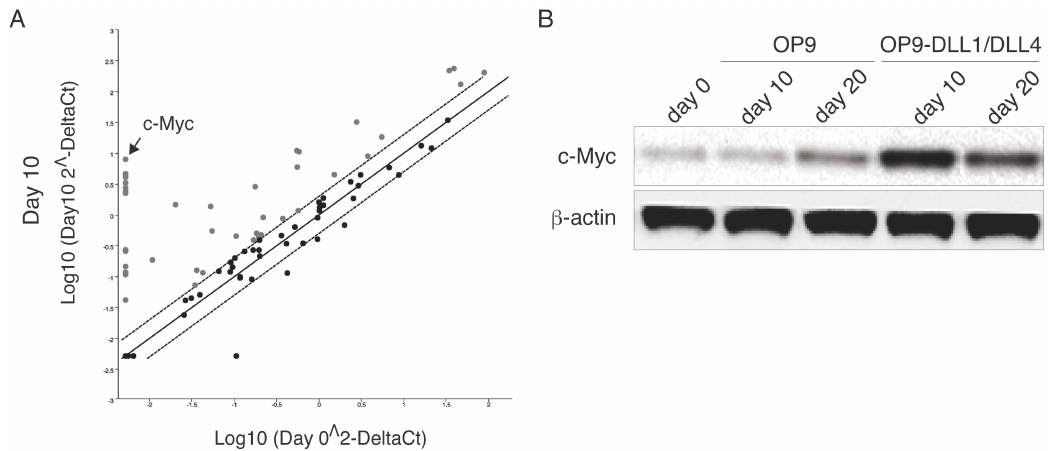
Figure 2. Notch signaling regulates c-Myc during HSC-T cell differentiation. Bone marrow–derived CD117 + HSCs from OT-I TCR transgenic mice were co-cultured with OP9-DLL1/DLL4 or OP9 cells. HSC-derived cells were isolated by gentle repetitive pipetting and centrifuging of the pipetting cells. ( A ) The scatter plots of PCR Array analysis. At days 0 and 10, total RNA (1 μ g) was isolated from HSCs or HSC-derived cells co-cultured with OP9-DLL1/DLL4 cells for the RT 2 Profiler PCR Array; ( B ) Detection of protein expression of c-Myc and β -actin by immunoblot. Identical results were obtained in three independent experiments.